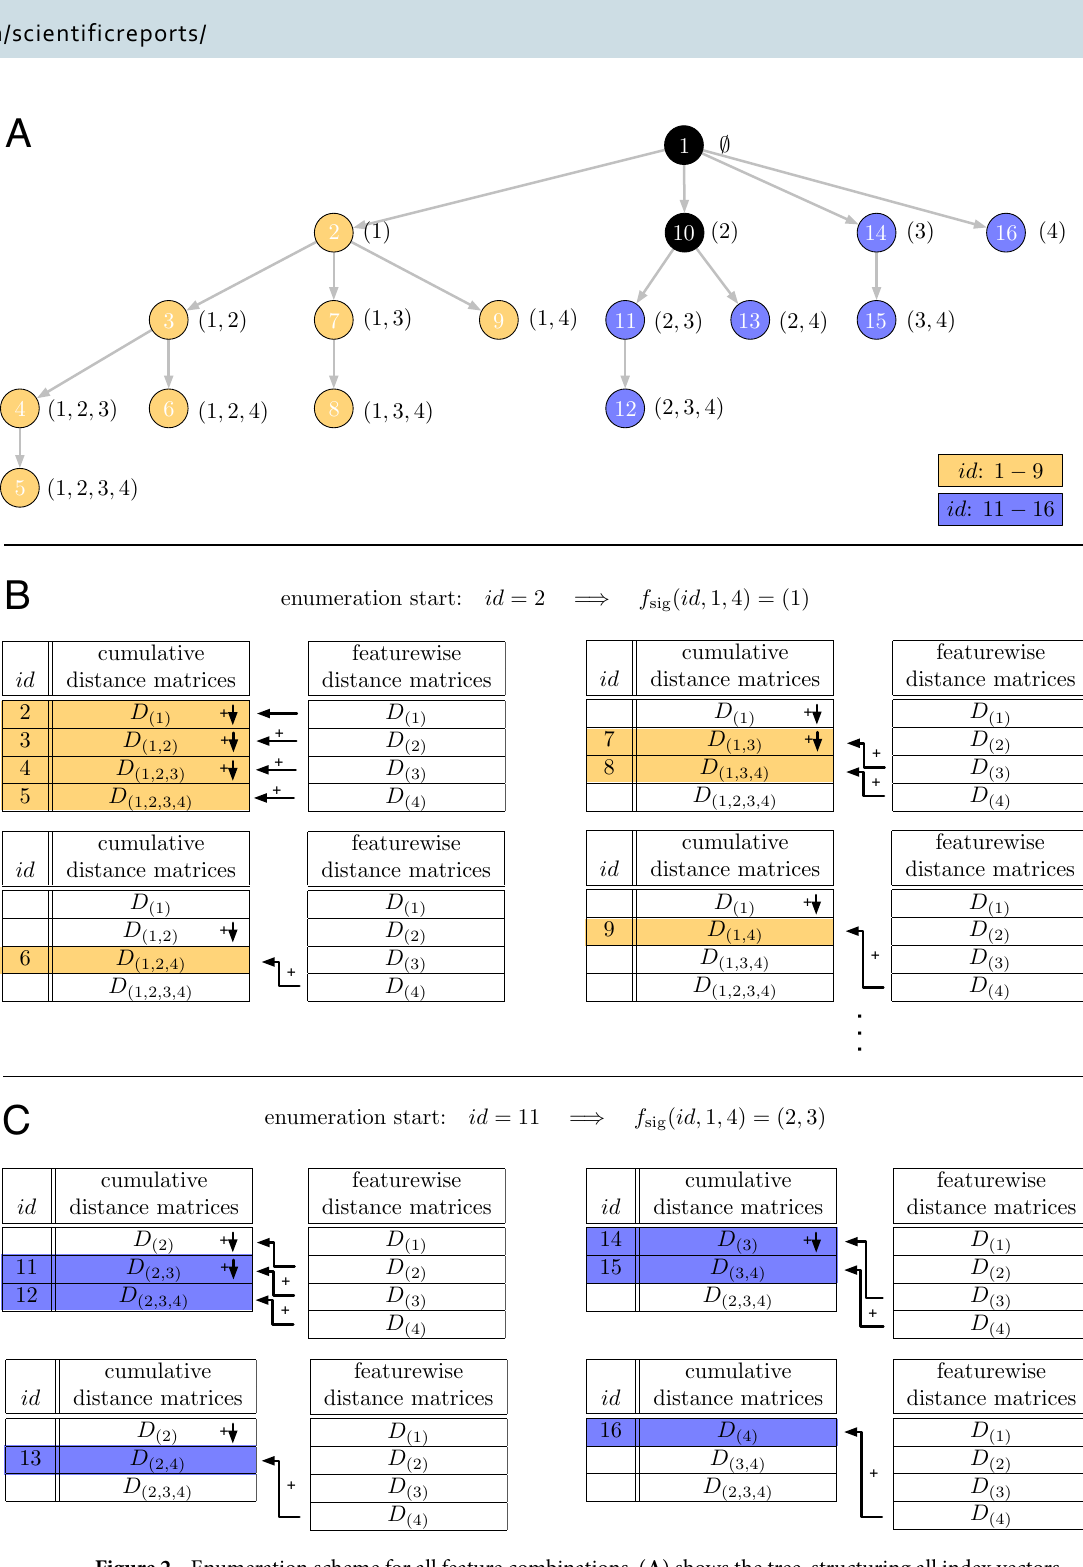
Figure 2. Enumeration scheme for all feature combinations. ( A ) shows the tree, structuring all index vectors for n = 4 features according to the parent relationship. Filled circle numbers give the sequence of evaluation, numbers in parentheses show the chosen feature numbers. ( B ) and ( C ) give examples for the in-place update of the cumulative distance matrices. The memorized cumulative and feature-wise distance matrices are shown. The arrows indicate the distance matrices that are utilized for calculating the cumulative distance matrix with index id . The lookup structure consists of at most 2 n distance matrices. The example of panel B starts the updates from the beginning of the sequence ( id = 2 ). The example of panel C is started by an arbitrarily chosen feature set index ( id = 11